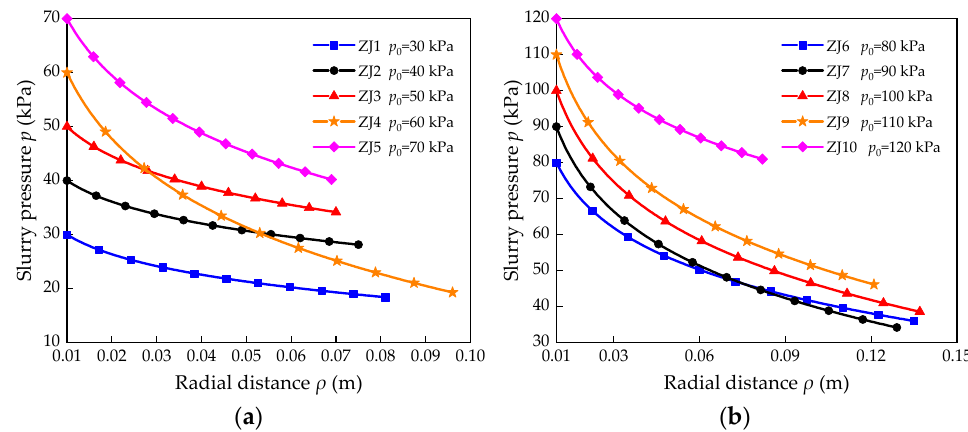
Figure 5. Pressure attenuation curve in the permeation and diffusion region, which was drawn by Equation (41): ( a ) ZJ1–ZJ5; ( b ) ZJ6–ZJ10. ‐ p ρ curve is represented by the slurry pressure